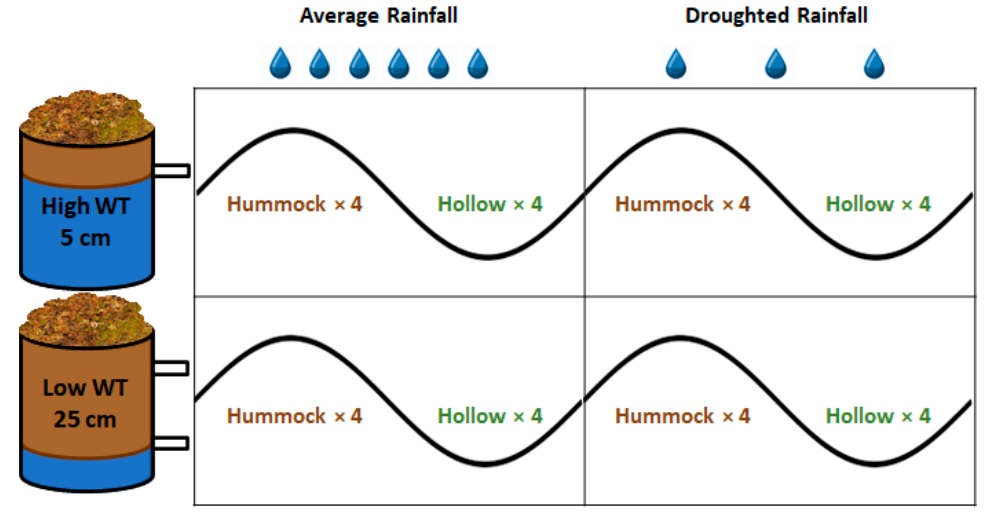
Figure 1. The experimental design was a fully factorial combination of landform (Hummock vs. Hollow), water table (High vs. Low), and Rainfall (Average vs. Droughted), with 4 replicate sphagnocosms per treatment level. Each sphagnocosm received an average (400 mL) or droughted (200 mL) rainfall treatment, along with a high (5cm from the initial peat surface) or low (25 cm from the initial peat surface) water table treatment, which were maintained via drainage valves indicated on the left of the figure.